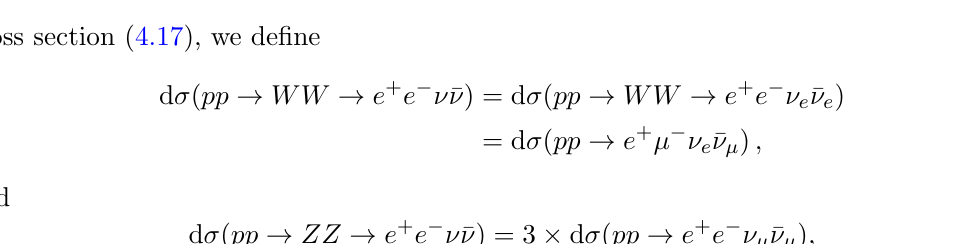
Figure 15 . Distribution in the azimuthal separation of the e + (cid:22) (cid:0) pair, (cid:1) (cid:30) at 13 TeV. Details as in (cid:12)gure